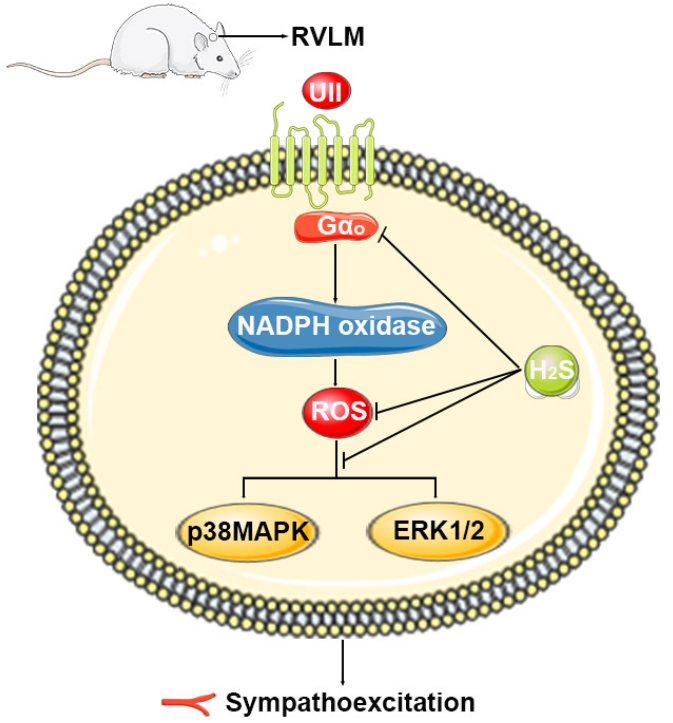
Figure 11. Schematic diagram of the mechanism of H 2 S in UII-induced cardiovascular